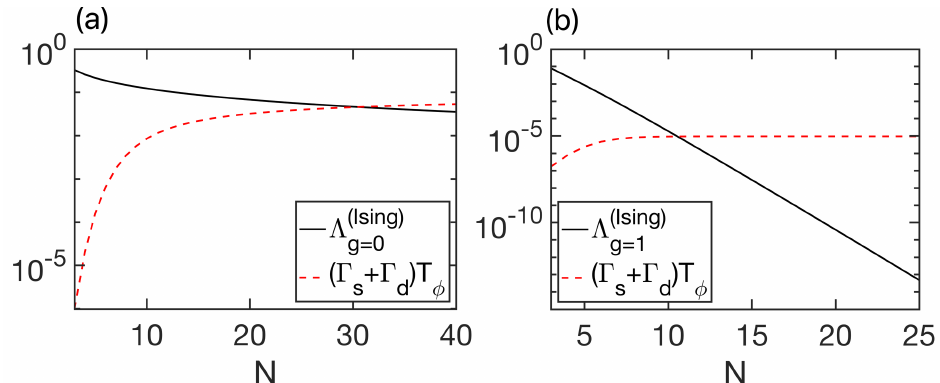
( Ising ) , Γ and Γ at g s d = 2 B . Notice the different x